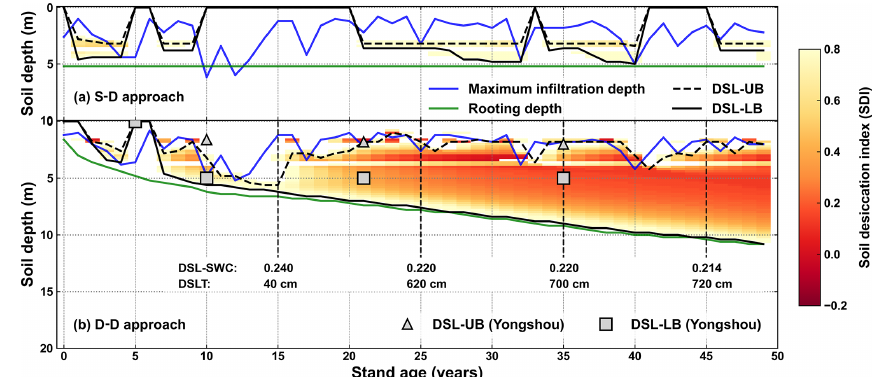
Figure 12. Evolution of the drying soil layers with stand age simulated by (a) the static rooting depth (S–D) and (b) the dynamic rooting depth (D–D) approaches over a 50-year period at Yongshou, Loess Plateau. The triangles and squares are the respective observed upper and lower boundaries adopted from Jia et al. (2017a). The abbreviations used in the figure are as follows: DSL-UB – the upper boundary of the drying soil layer; DSL-LB – the lower boundary of the drying soil layer; DSL-SWC – the mean soil water content within the drying soil layer; DSLT – the thickness of the drying soil